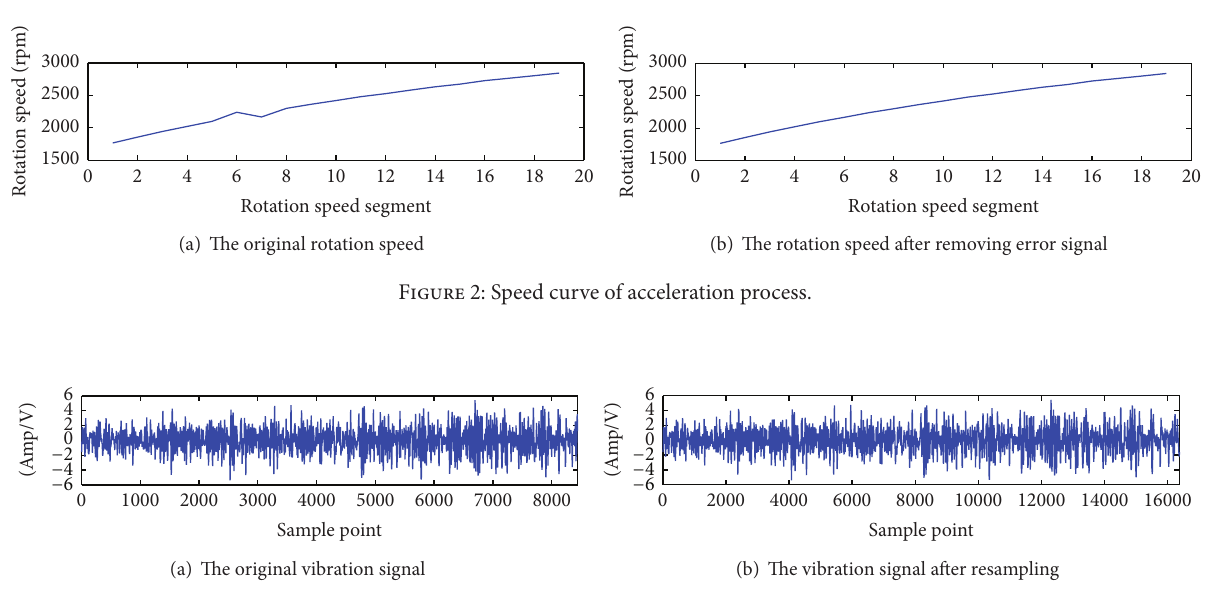
Figure 3: Vibration signal of acceleration